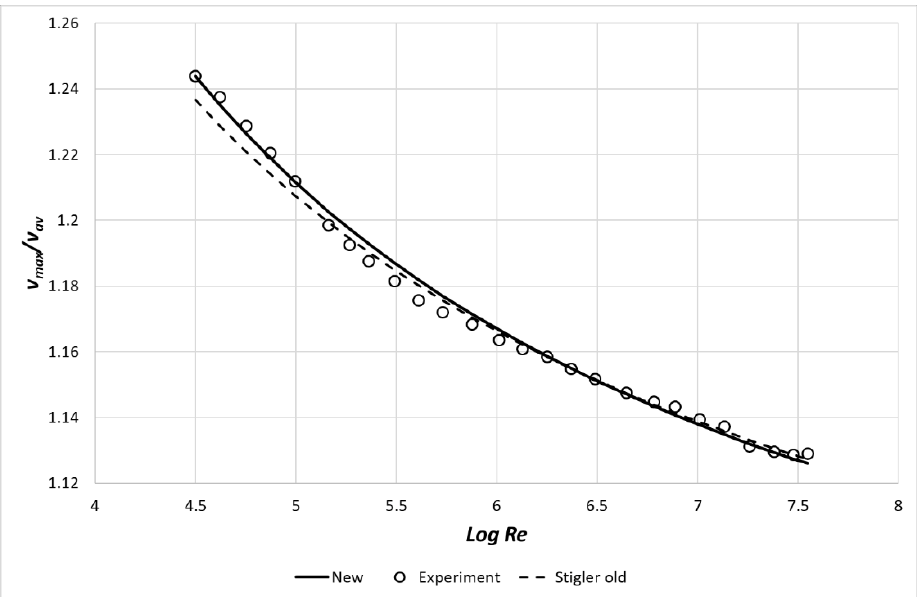
Figure 8. The dependence of the normalized maximal velocity on the Re.